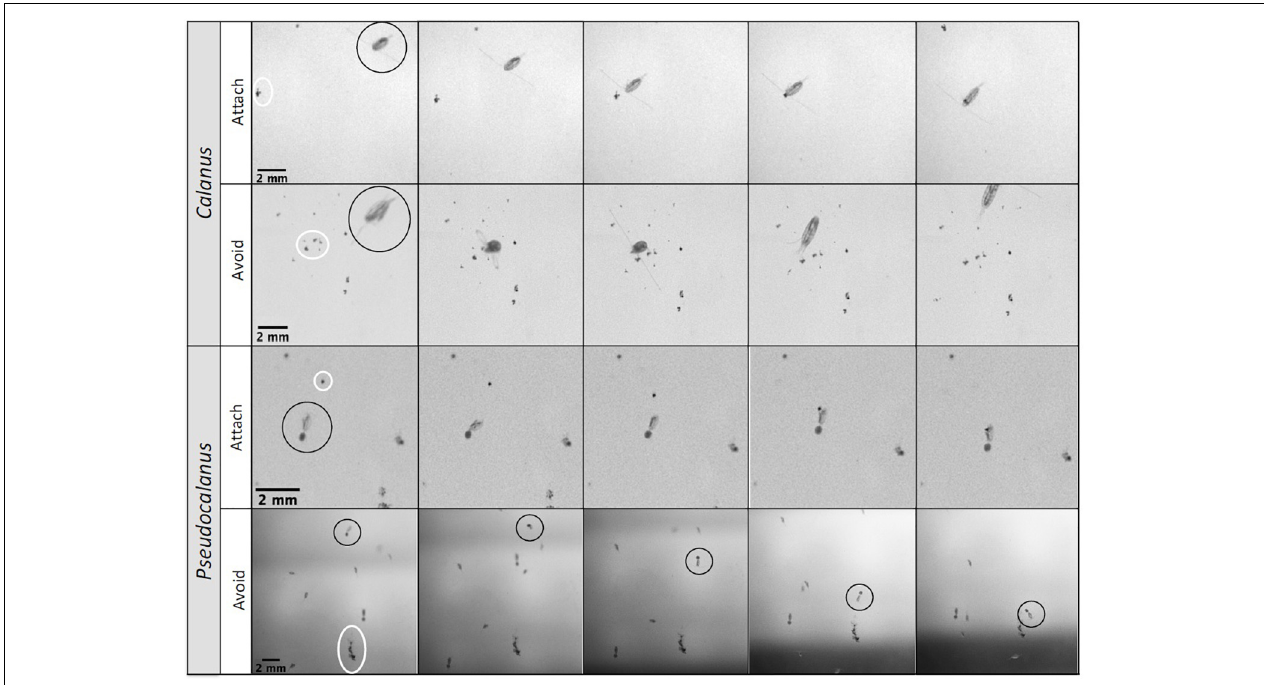
FIGURE 2 | Stills from videos with interactions between copepods (marked with black circles) and sinking aggregates (marked with white circles). Calanus Attach: Calanus spp. swims from the side toward an aggregate and attaches to it. Calanus Avoid: Calanus spp. swims, changes course, touches an aggregate with its swimming legs (3rd photo), and jumps away. Pseudocalanus Attach: Pseudocalanus spp. female is filter feeding, jumps, swims toward the sinking aggregate, attaches to the aggregate with its swimming legs, and sinks while feeding. Pseudocalanus Avoid: Pseudocalanus spp. (circle) swims back and forth 13 mm above a sinking aggregate, follows its trail down, but swims away from the aggregate when in the vicinity.